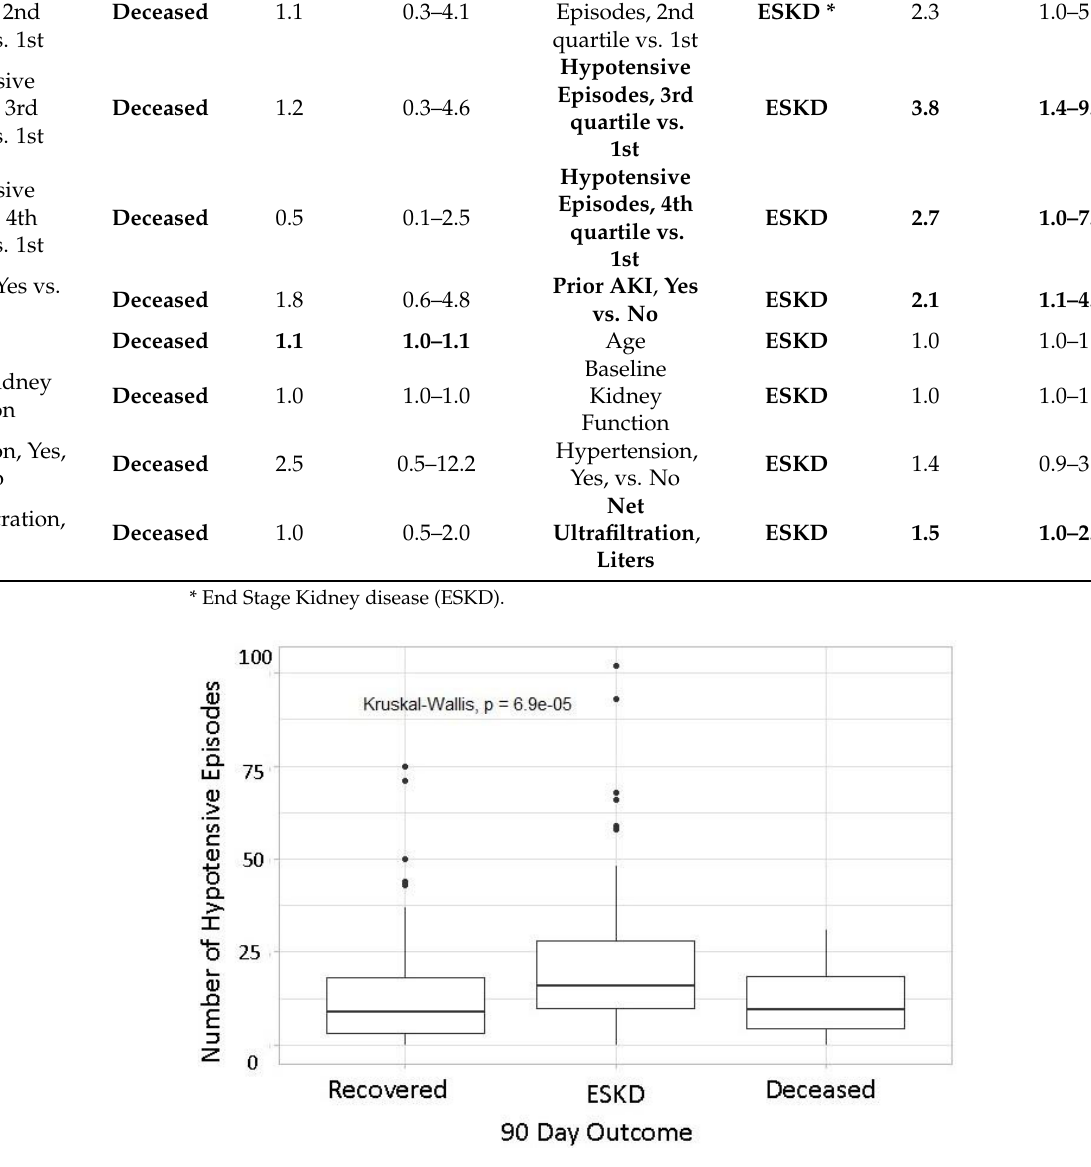
Figure 1. Analysis of number of Intra Dialytic Hypotensive (IDH) episodes across all sessions in the first 4 weeks. ESKD: End Stage Kidney disease.